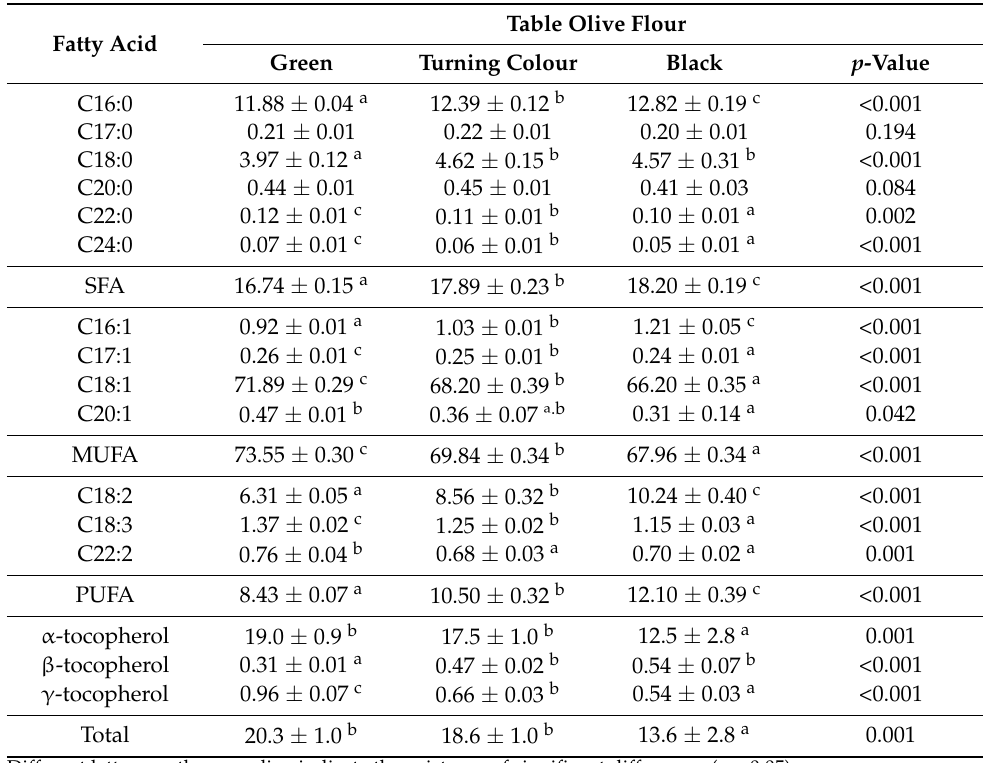
Green Turning Colour